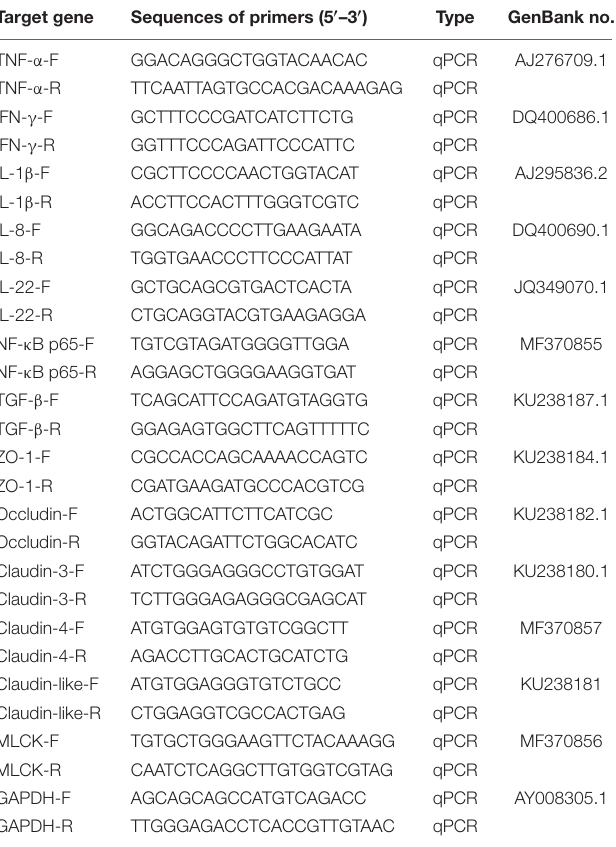
TABLE 2 | Primers used for quantitative real-time PCR analysis. Target gene Sequences of primers (5 (cid:48) –3 (cid:48) ) Type